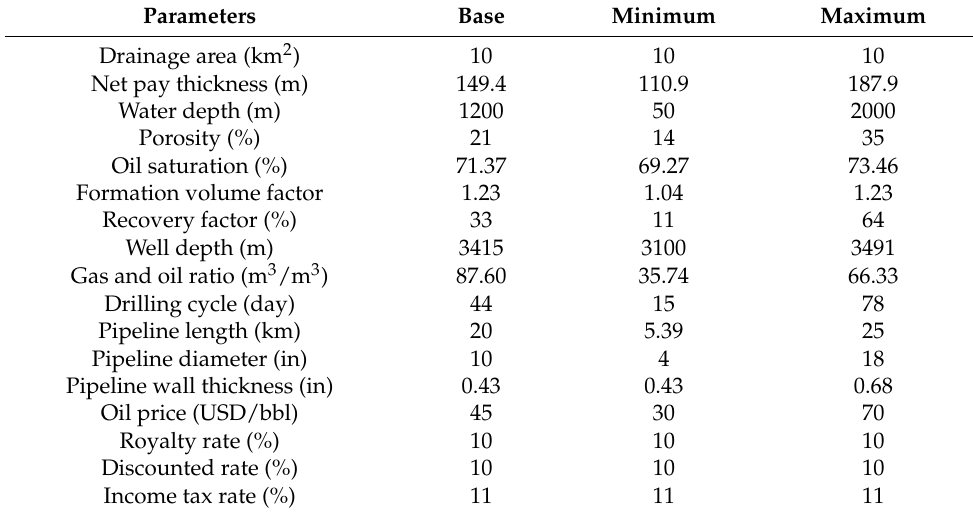
Table 2. Input parameters of the